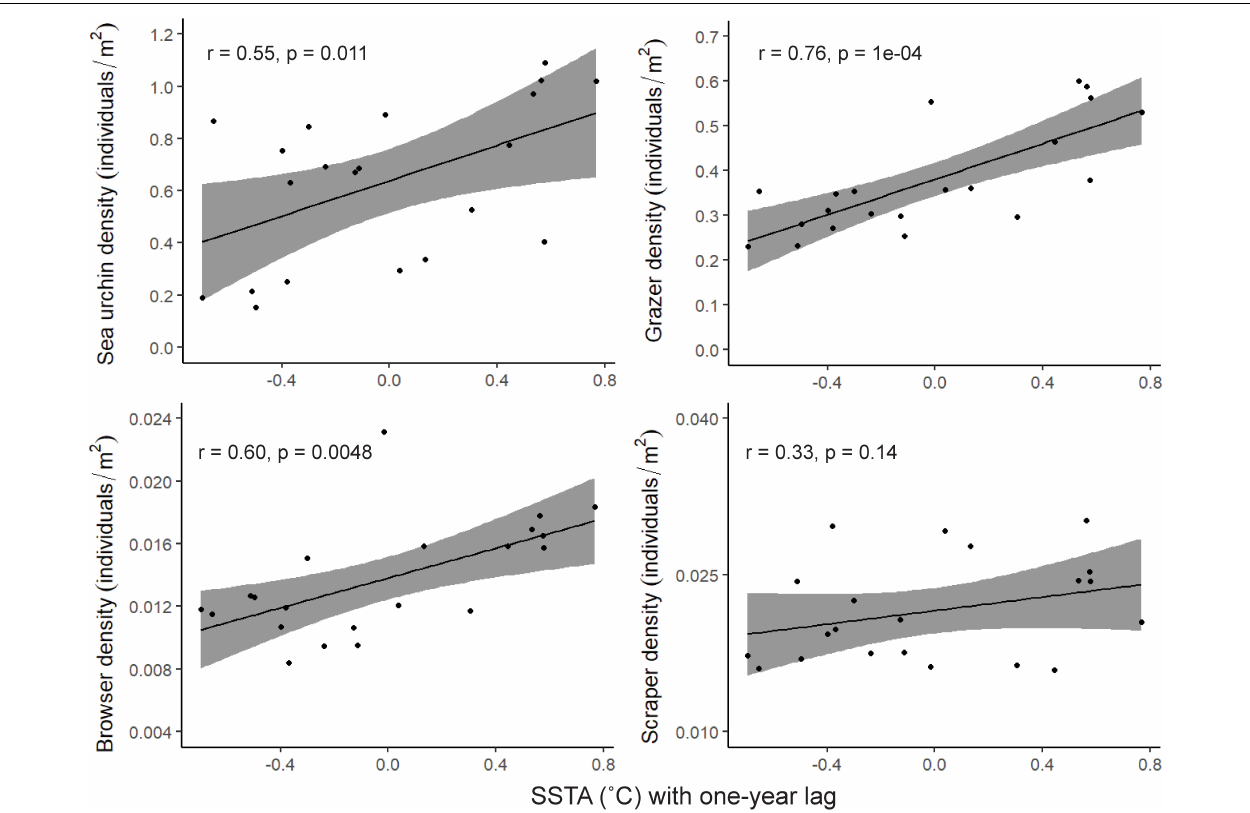
FIGURE 3 | Relationships between herbivore density and sea surface temperature anomalies. Each point represents the mean density across the 25 survey sites plotted with the mean SSTA for the previous year. The Pearson correlation coefficient, r, and significance of the relationship are shown for each